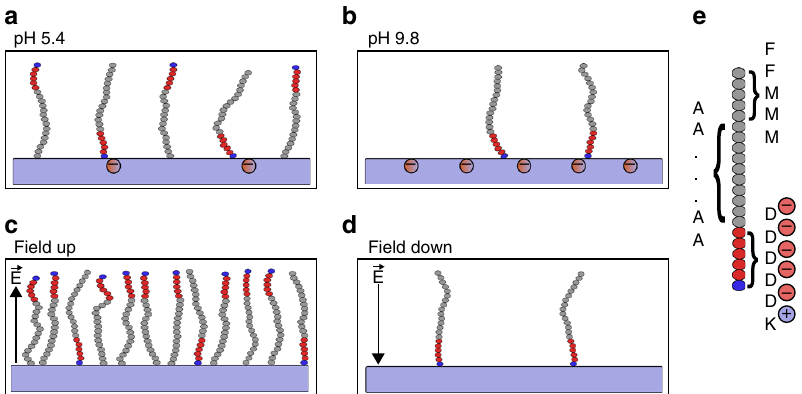
Fig. 6 Illustration of peptide orientation and concentration. The immobilization conditions were a pH 5.4, b pH 9.8, and with applied electric fi elds c E up and d E down both at pH 5.4. The radical-functionalized plasma polymer surface is indicated by purple rectangles, with charges on both the surfaces and the peptide indicated by circled + or – signs. e The enlarged peptide indicates the position of amino acids (lysine (K) blue, aspartic acid (D) red, and all others shown in